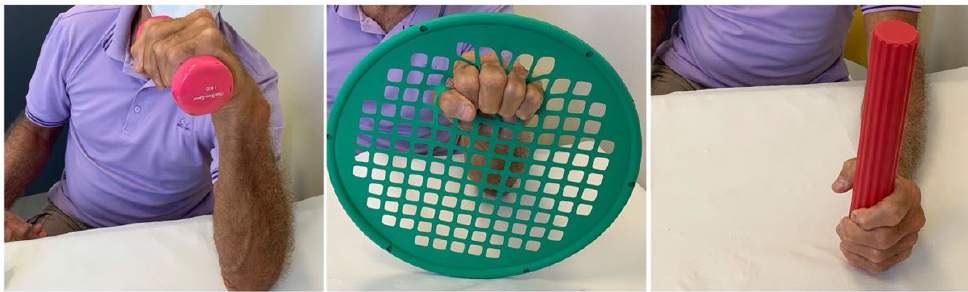
Figure 4. Illustration of sessions of musculature strengthening and proprioceptive exercises per- formed within Path A1 and Path A2 rehabilitative protocol.